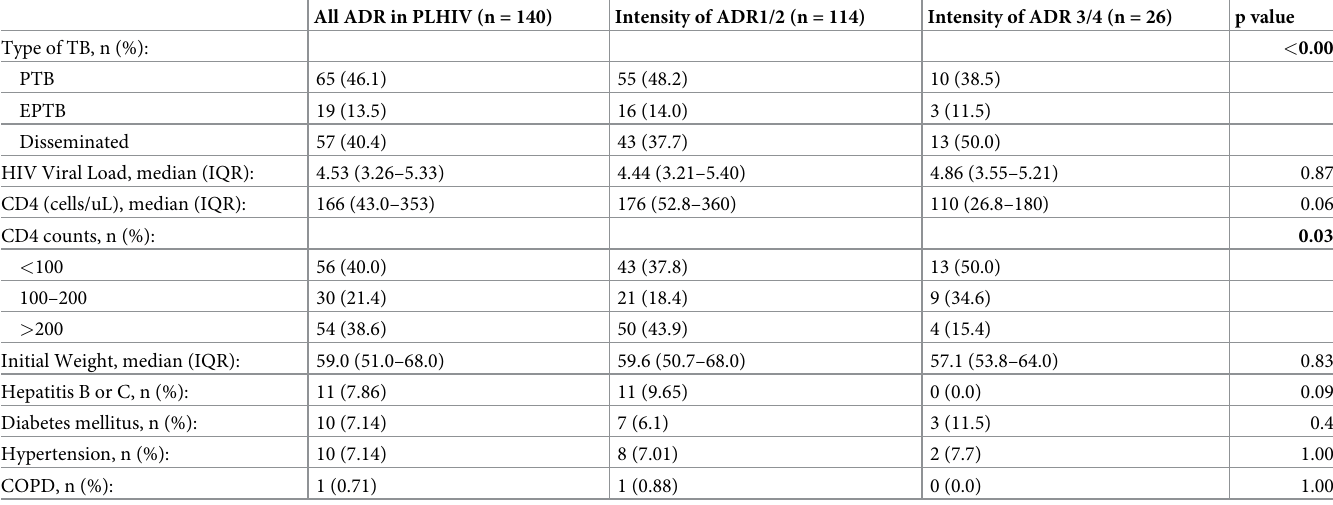
Table 4. Clinical and laboratory characteristics according to intensity of ADR in PLHIV. All ADR in PLHIV (n = 140) Intensity of ADR1/2 (n = 114) Intensity of ADR 3/4 (n = 26) p